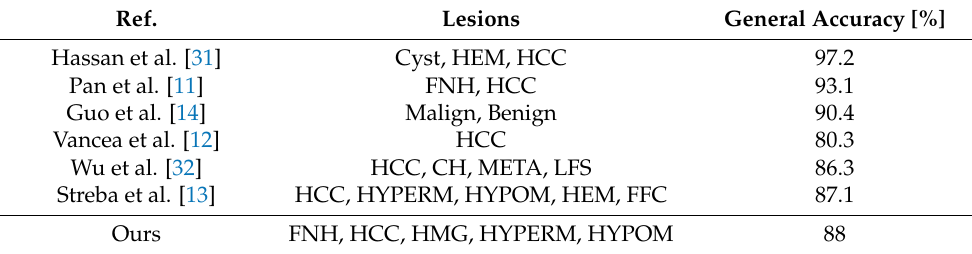
Table 11. State-of-the-Art